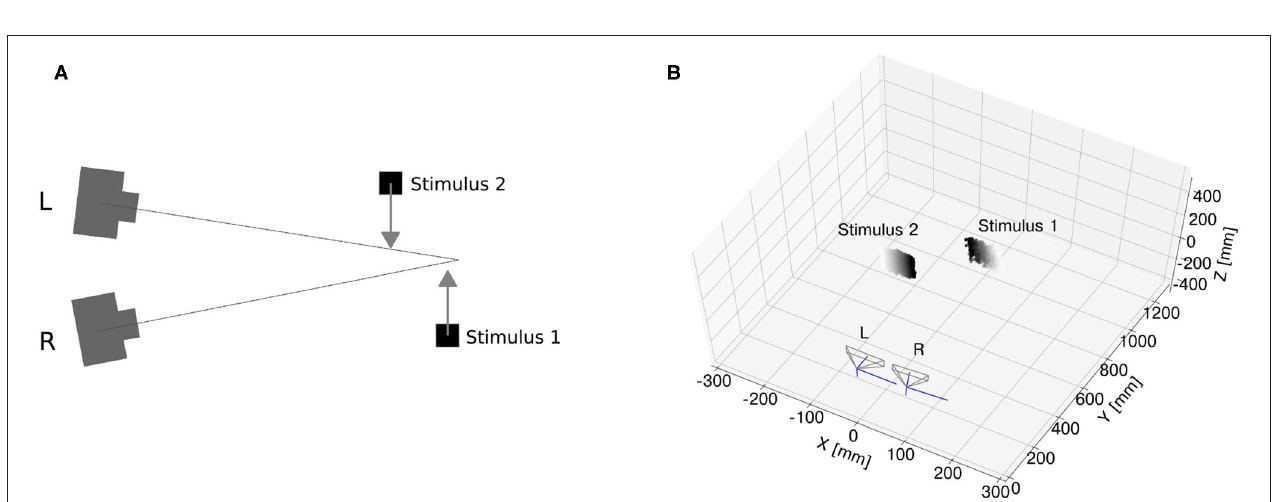
FIGURE 6 | Event camera dataset. Sketch of experimental setup (A) two monitors were used for the generation of two edges separated in depth and moving on a plane. After calibration, the monitor generating Stimulus 1 was placed closer to the region of the camera vergence point, while Stimulus 2 was placed closer to the stereo setup. Pointcloud reconstruction (B) with generalized time-based technique (time window ǫ = 2 ms, exponential decay kernel τ = 10 ms and a spatial kernel of 10 × 10